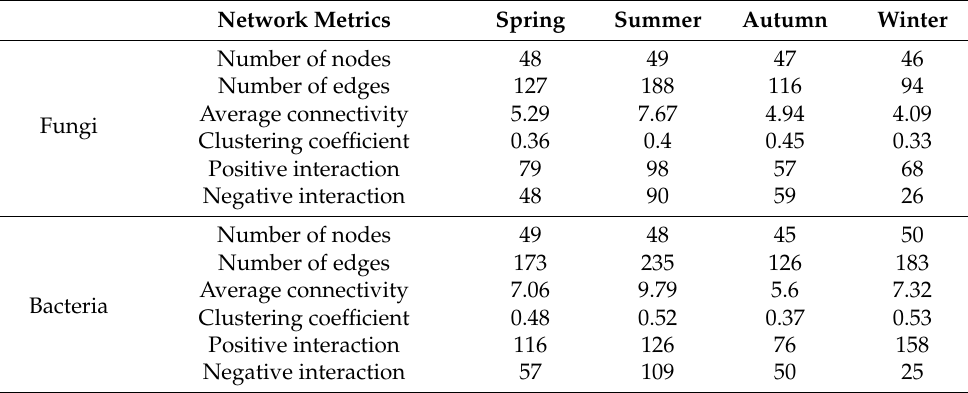
Table 2. Microbial network properties at four